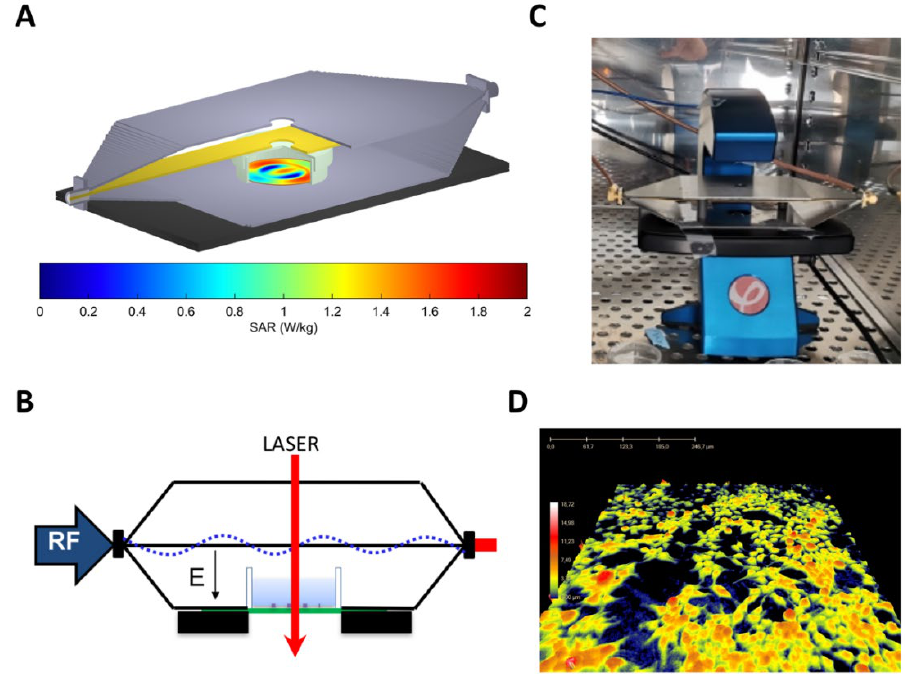
Figure 7. Experimental device for exposing cells to RF while acquiring digital holographic microscopic images. ( A ) Normalized S.A.R. distribution at the cell level in the delivery system at 1800 MHz. ( B ) Cross-section of the TEM cell in which a cell culture dish has been placed. The picture indicates the propagation of the RF electric field and the LASER path only at the center of the cell culture plate. ( C ) Photography of the TEM cell placed on the HoloMonitor M4 platform. A hole has been drifted in both ground planes and septum of the TEM cell to allow light to go through the cell culture. ( D ) Example of a digital holographic microscopy image of a SH-SY5Y cell culture. The color scale provides information on the height of the cells.